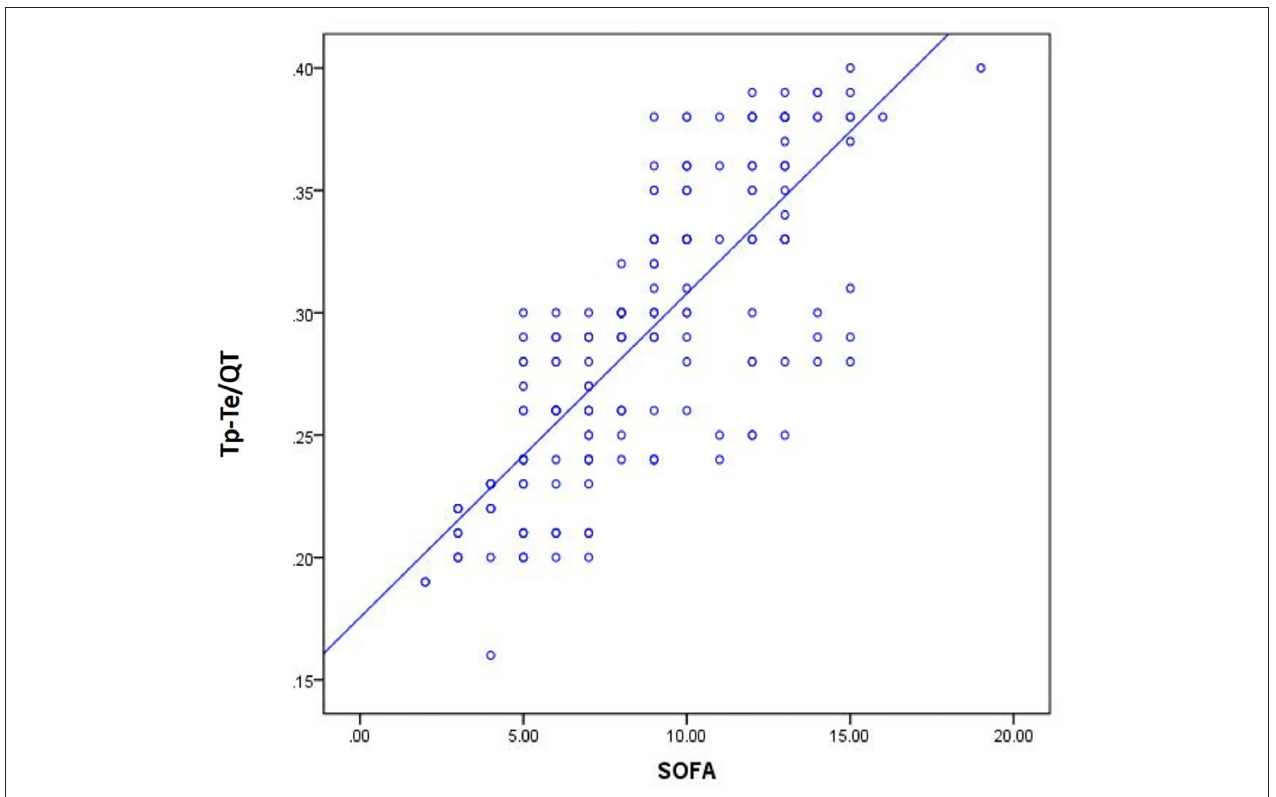
FIGURE 3 | Scatter plot of correlation between Tp-Te/QT and SOFA. TABLE 7 | Incidence of arrhythmia in patients with sepsis with different TDRs. Groups patients withnewarrhythmia